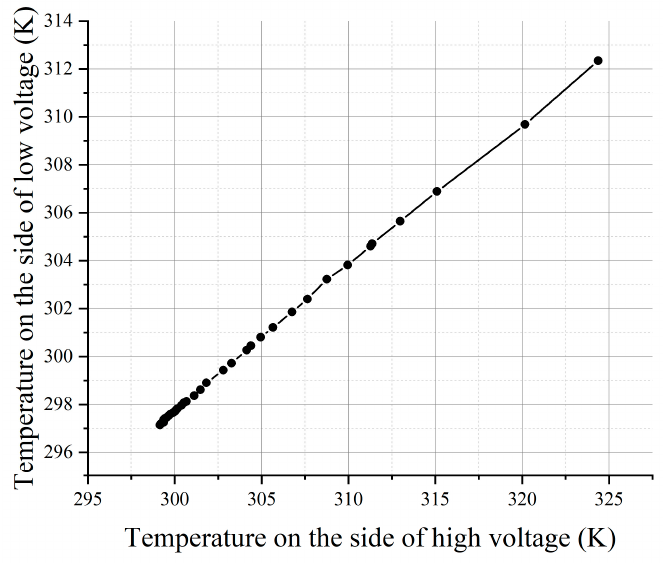
Figure 8. The in-plane thermal measurement result.